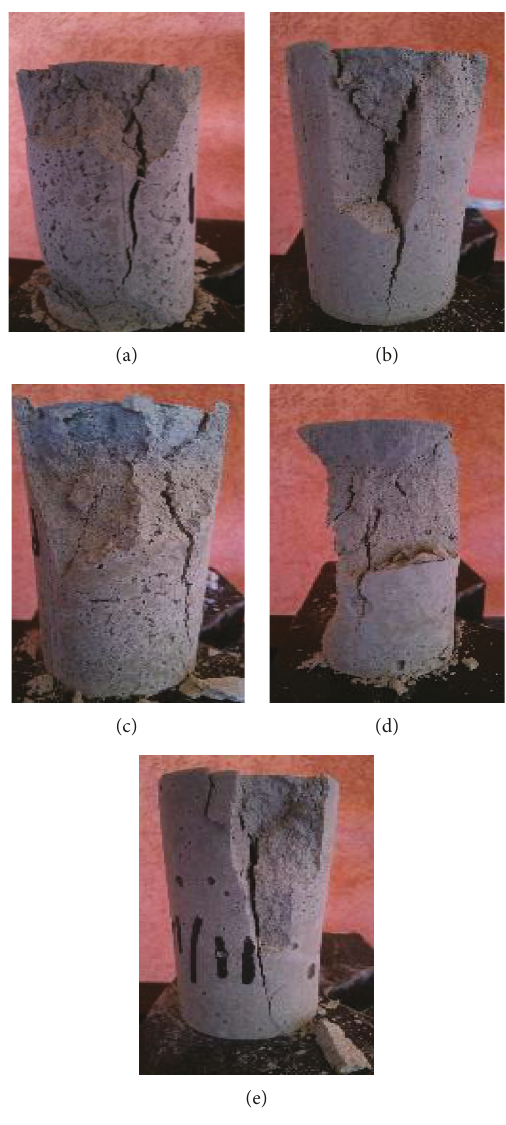
Figure 12: Types of fractures in samples at 14 days. Mixtures (a) M1, (b) M3, (c) M7, (d) M8, and (e) M11 with higher per- formance, respectively, from the left side (own